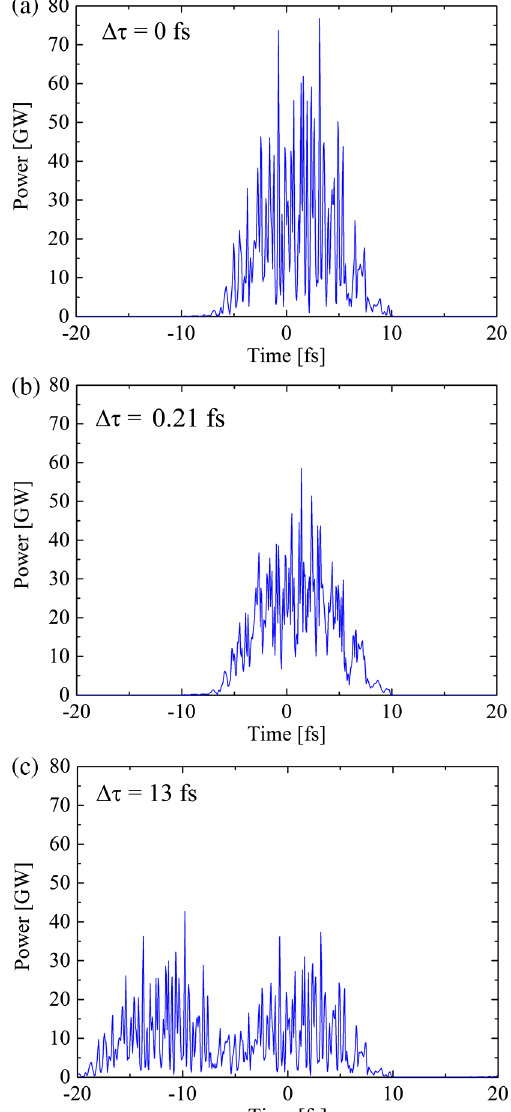
FIG. 3. The temporal shape of the FEL pulse at h ν ¼ 4 . 96 keV for (a) zero delay, (b) τ ¼ 0 . 21 fs and (c) τ ¼ 13 fs where the split pulses are clearly